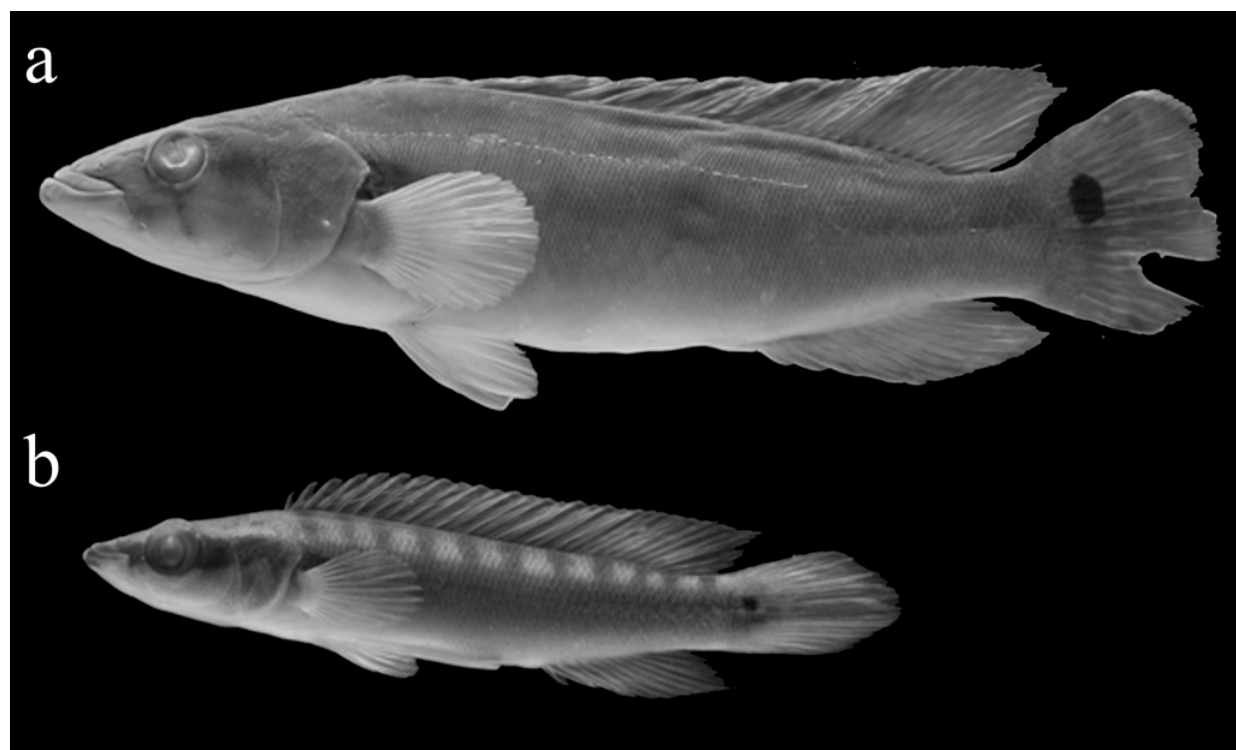
Fig. 1. Specimens of (a) Crenicichla lugubris (217 mm SL) and (b) C . aff. wallacii (51 mm SL) from the Cinaruco River,